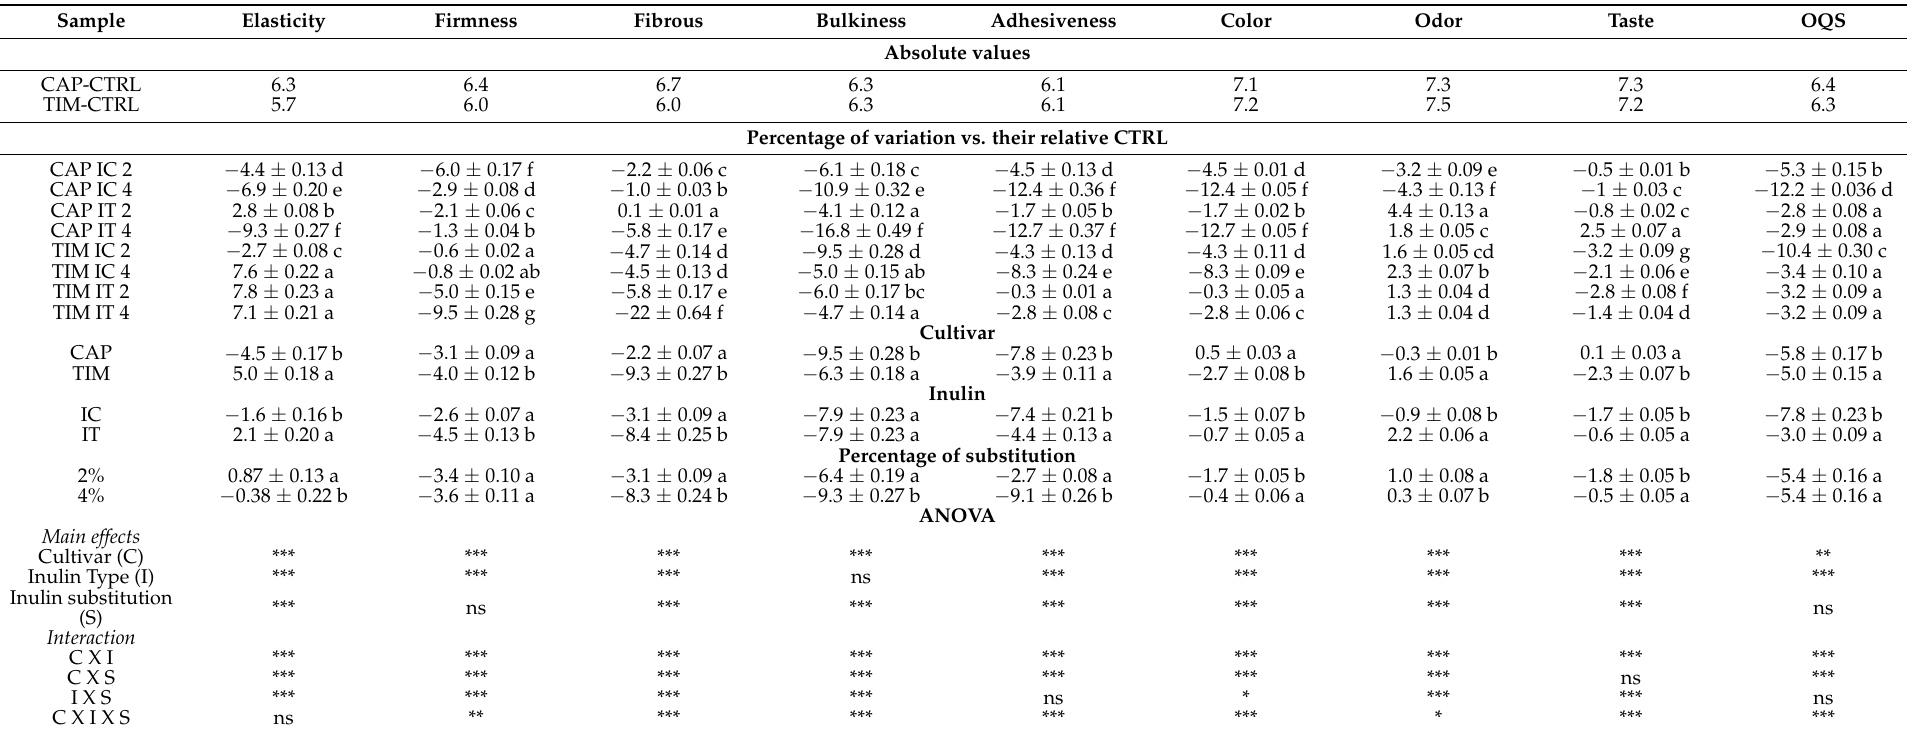
Table 3. Sensorial attributes (mean ± SD; n = 15) of all cooked spaghetti. Different letters in each column indicate statistical differences at p < 0.05 (Duncan’s